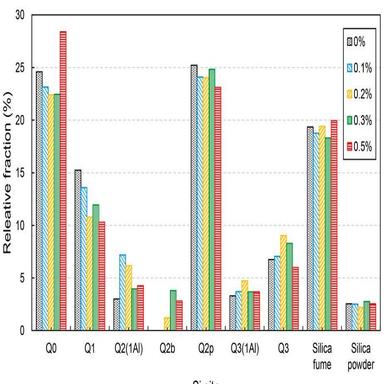
Relative Si fraction (%) of the samples as calculated from the deconvolution of 29Si NMR spectra.